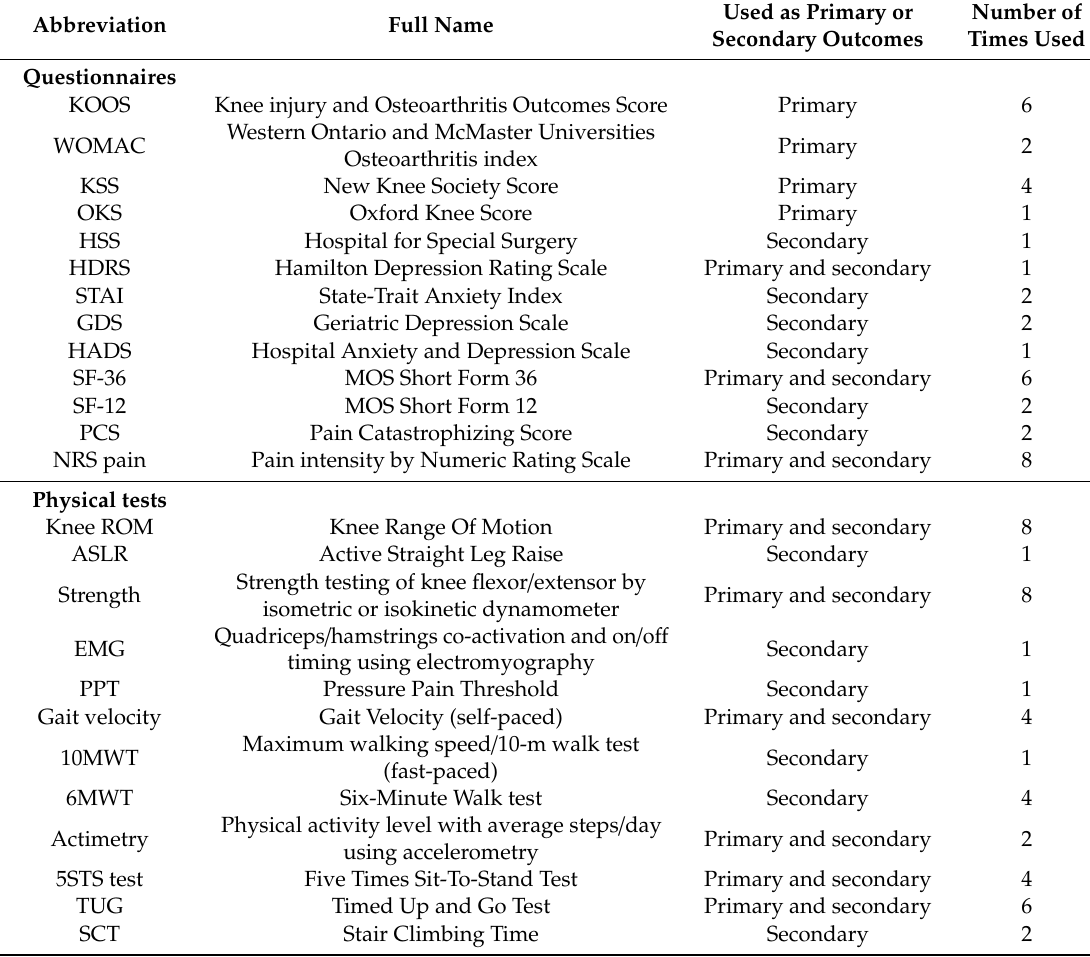
Table 2. Summary of knee osteoarthritis (OA) outcomes used in included